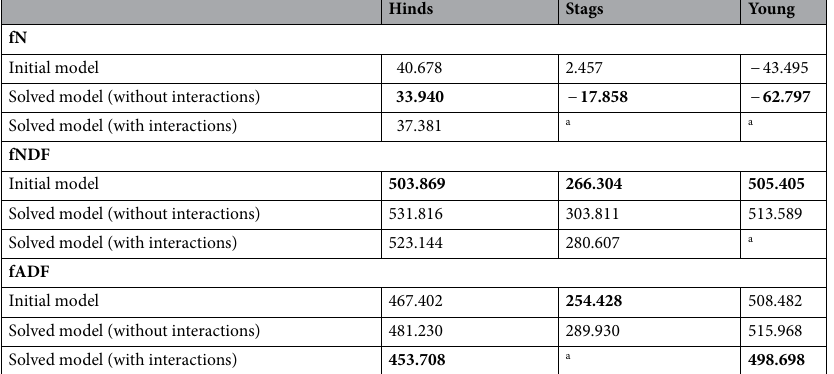
Table 2. Corrected Akaike´s Information Criterion (AICs) values of each of the three models prepared for each dataset and faecal nutrients (nitrogen—fN; neutral detergent fibre—fNDF; acid detergent fibre—fADF). The selected models, those with lower AICc value, are highlighted in bold. Only these models are described and discussed. a The solved model was the same as the solved model without